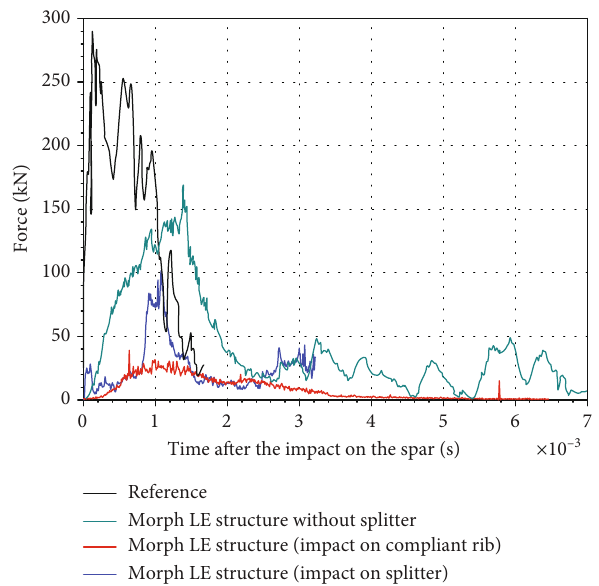
Figure 28: Bird strike test: reaction force on the front